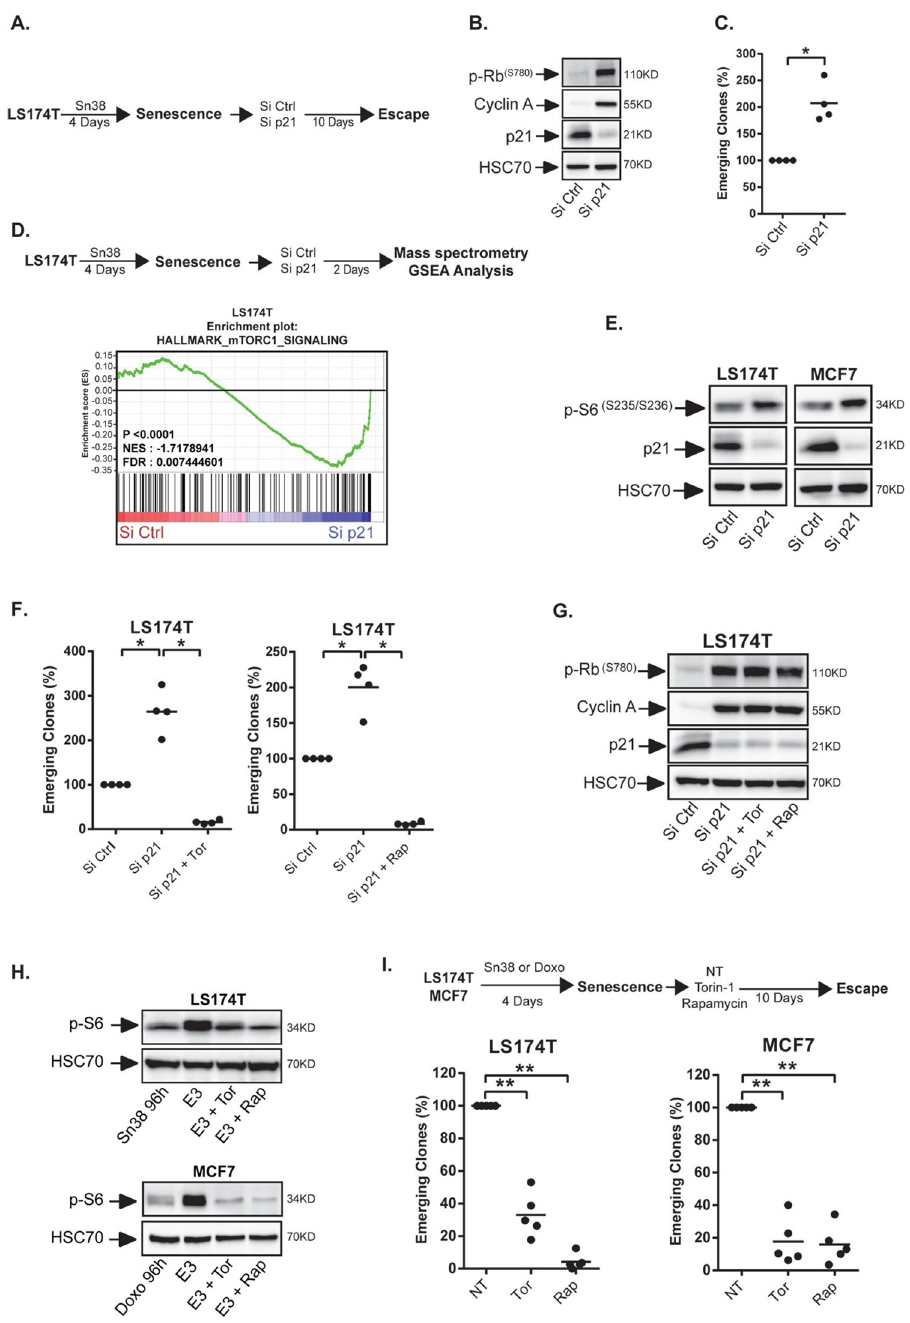
Fig 1. mTOR is necessary for senescence escape. A. Senescence was induced by treating LS174T colorectal cells with the topoisomerase I inhibitor sn38 as indicated. Cells were then washed with PBS and transfected with a control siRNA or a siRNA directed against p21 for 24 hr and senescence escape was generated by adding 10% FBS. B. LS174T cells were treated as above and cell extracts were recovered 2 days after p21 depletion. The expression of the indicated proteins was analyzed by western blot (n = 3). C. Number of emerging clones analyzed after p21 inactivation (n = 4, Kolmogorov-Smirnov test � = p < 0.05). D. Senescent cells were transfected with a control siRNA or a siRNA directed against p21. Cell extracts were analyzed by SWATH quantitative proteomics and GSEA analysis 2 days after p21 depletion (n = 3). E. Validation of mTORCI activation by western blot 2 days after p21 inactivation in LS174T and MCF7 mammary cells (n = 3). F and G. Senescent LS174T cells were transfected with a control siRNA or a siRNA directed against p21 for 24 hr. Cells were then stimulated with 10% FBS in the presence or absence of mTOR inhibitors (Rapamycin: 5nM, Torin-1: 15nM). The number of emerging clones was evaluated after 10 days (F, n = 4,